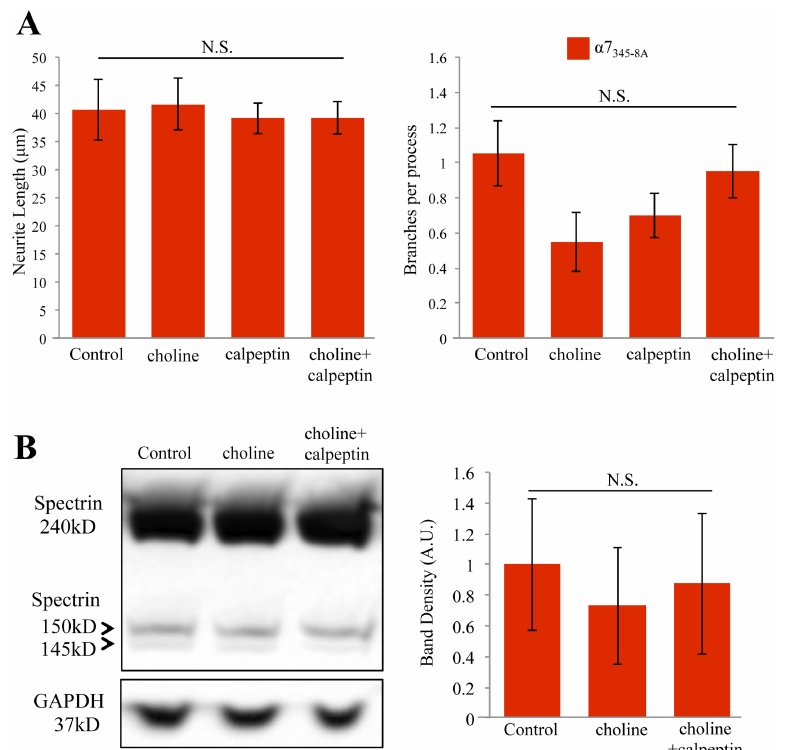
Fig 8. G protein coupling to the α 7 nAChR is necessary for calpain mediated cytoskeletal growth. (A) Average neurite length and branching in cells transected with α 7 345-8A at 3 days of NGF differentiation. Cells were treated with HBSS (Control), 1 mM choline, 26 μM calpeptin, or choline and calpeptin together. (B) Left, a western blot showing anti- α IIspectrin immunoreactive bands at 240 kD, 150 kD and 145 kD. Lanes were loaded with lysates from PC12 cells treated with 10 mM choline, 26 μM calpeptin then choline, or HBSS (Control). Right, band density analysis from 3 independent experiments showing the effect of drug treatment on α IIspectrin breakdown. (N.S. not significant; n = 20 cells per group for morphometric data; n = 3 independent experiments for western